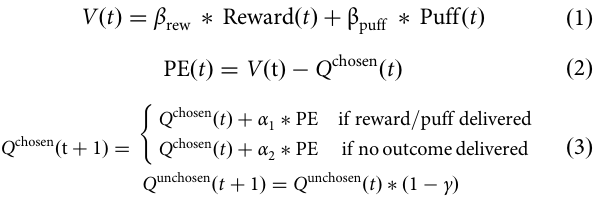
(Supplementary Fig. 2m). Neurons encoding all three factors had